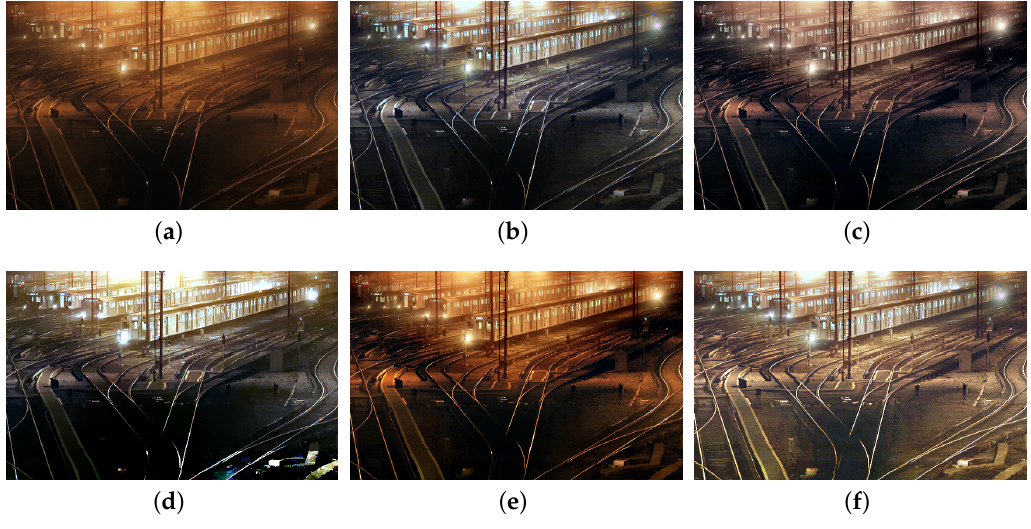
Figure 14. Comparisons with other nighttime dehazing methods on test image Railway